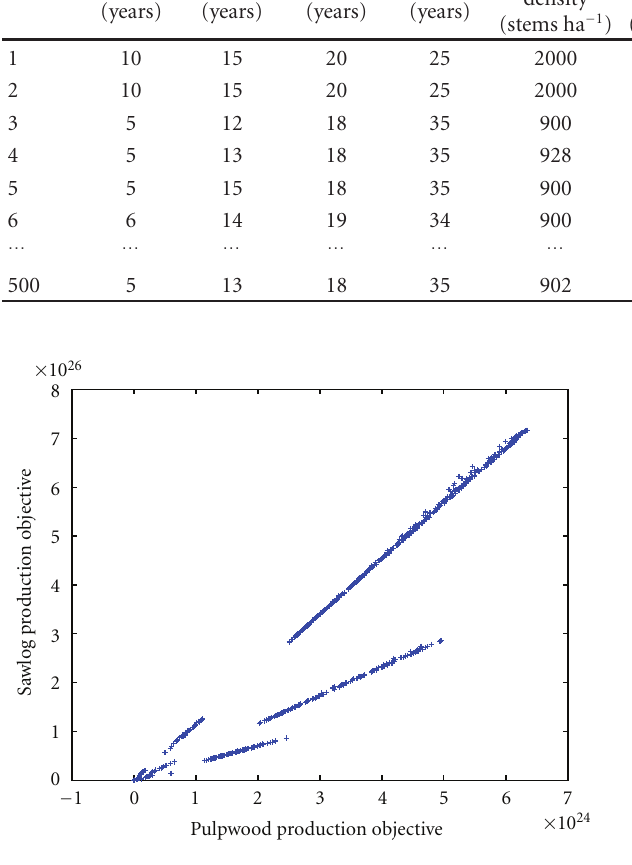
Figure 4: Disjointed Pareto front as predicted by the NSGA II. Figure 5: Superimposed Pareto fronts from MOGA and NSGA